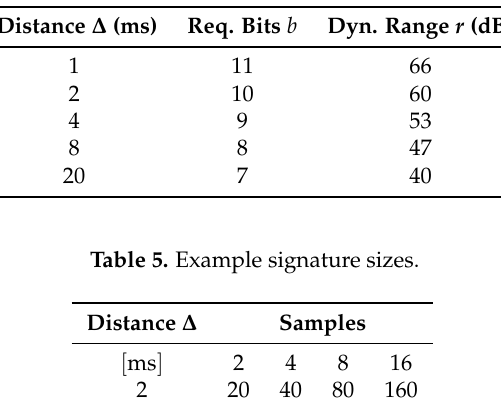
Table 4. Quantization per sample.